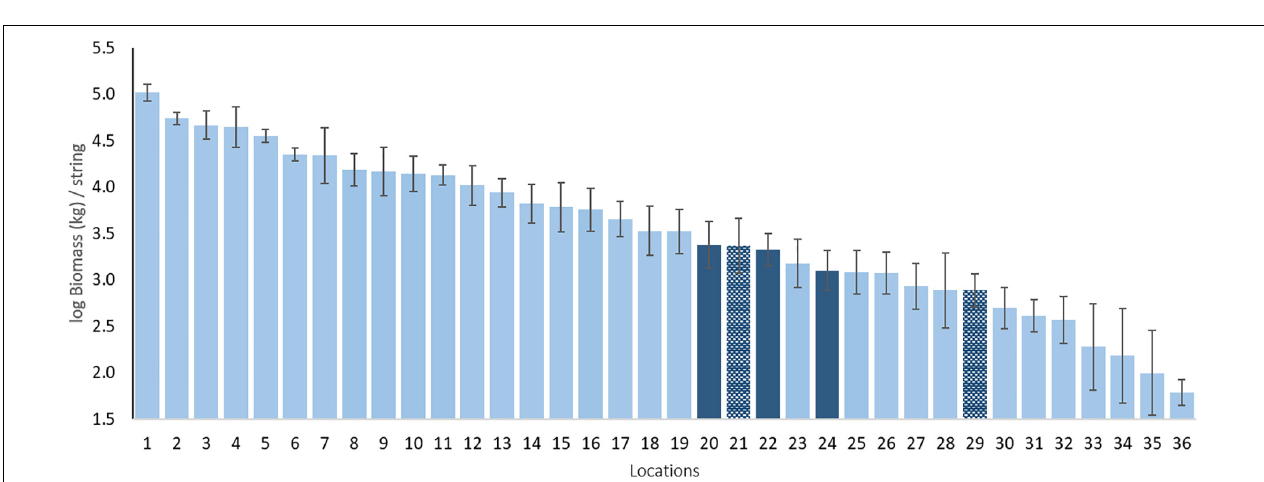
FIGURE 1 | Location of mid-water BRUVS surveys undertaken since 2012 (www.meeuwig.org/resources) and cumulative increase in the number of surveys per year.